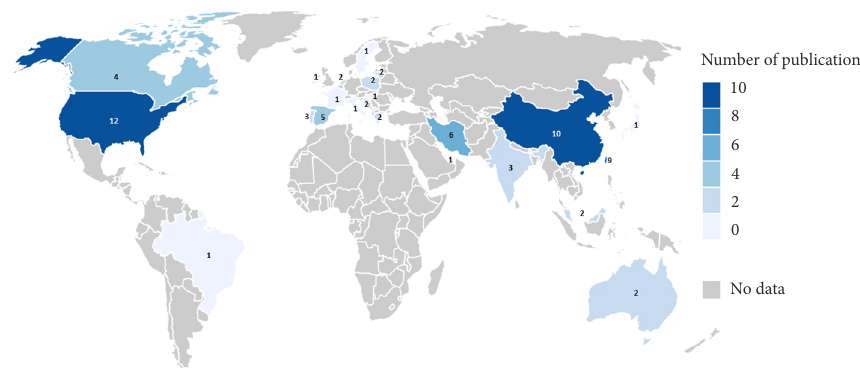
Figure 3. Distribution of publications by